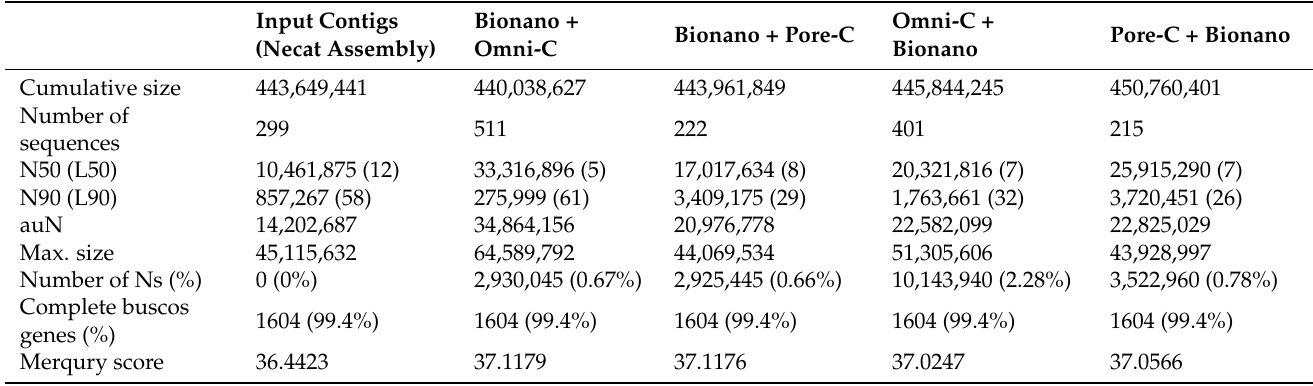
Table 2. Metrics of scaffolds generated by using a combination of different scaffolding technologies, compared to input contigs. Statistics were generated using sequences of more than 30 kb in size.